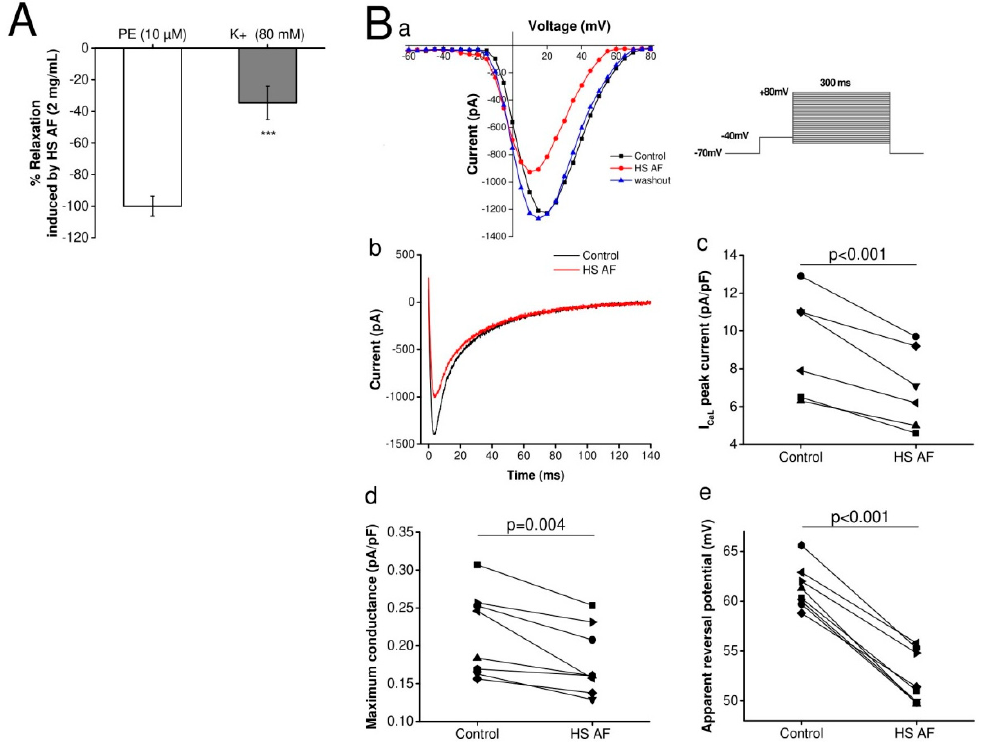
Figure 6. ( A ) Relaxant effect of 2 mg/mL HS AF on isolated Wistar rat MA rings pre-contracted